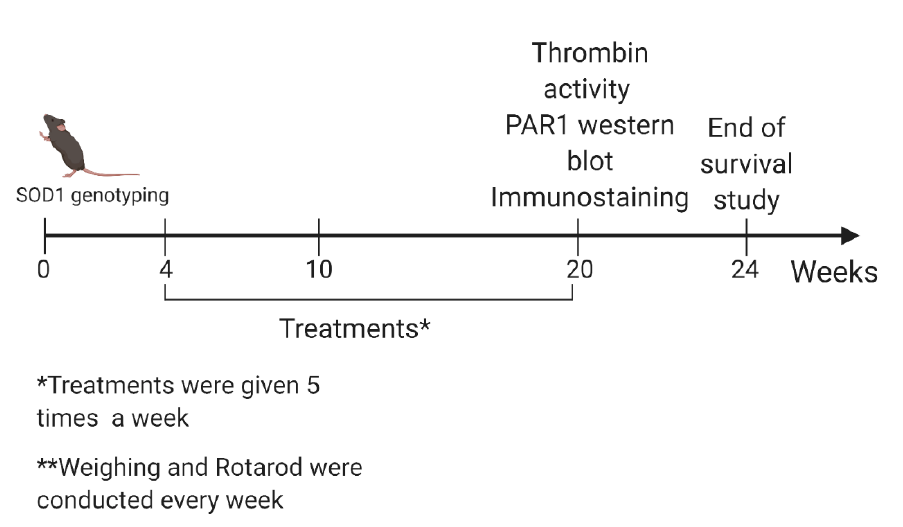
Figure 4. Timeline: transgenic mice were genotyped at birth. Weighing and rotarod evaluation were performed every week. Treatments were given at weeks 4–20, five times a week. Thrombin activity, western blot for PAR1 and immunostaining were conducted at the age of 20 weeks. In the survival arm of the study, mice were followed up until the age of 167 days.